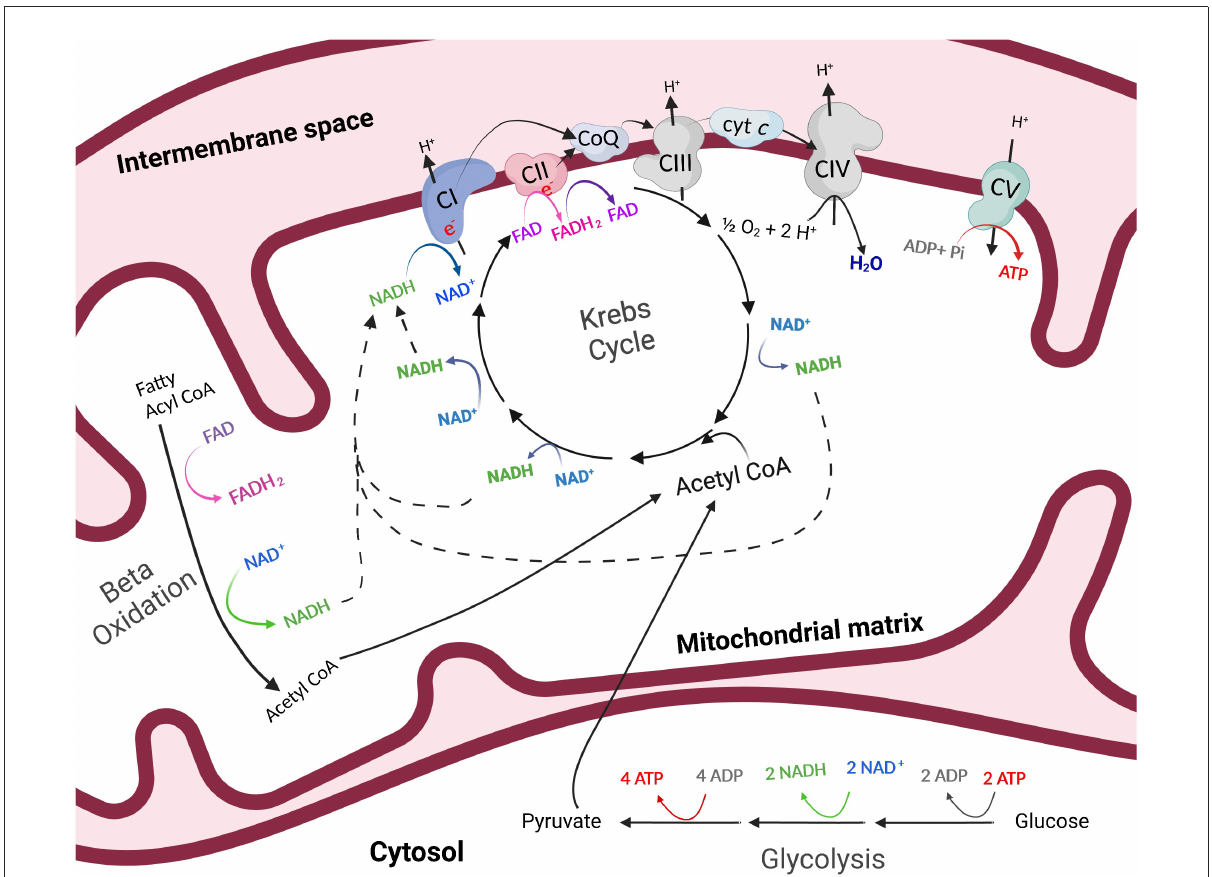
FIGURE1 The process of energy production outside of (glycolysis) and within (oxidative phosphorylation) the mitochondria. Through anaerobic glycolysis, glucose is metabolized in the cytosol of the cell to pyruvate. Pyruvate may then be transported into the mitochondria where it is oxidized to acetyl CoA, which enters the Krebs cycle in the mitochondrial matrix. The byproducts of the Krebs cycle, NADH and FADH 2 , provide high-energy electrons to the electron transfer system which resides in the inner mitochondrial membrane. As electrons are transferred, protons are pumped into the intermembrane space of the mitochondria and a proton gradient is generated. Protons then flow through ATP synthase, or complex V (CV) of the electron transfer system, following the chemical gradient to combine with adenosine diphosphate (ADP) and inorganic phosphate (Pi), creating ATP. This process is referred to as oxidative phosphorylation. Created with